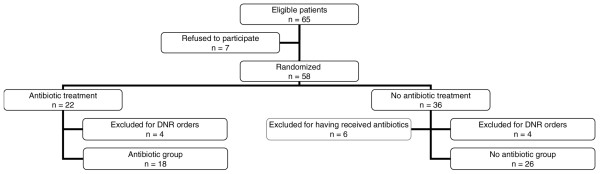
Profile of modified intention-to-treat analysis. DNR, do not resuscitate.